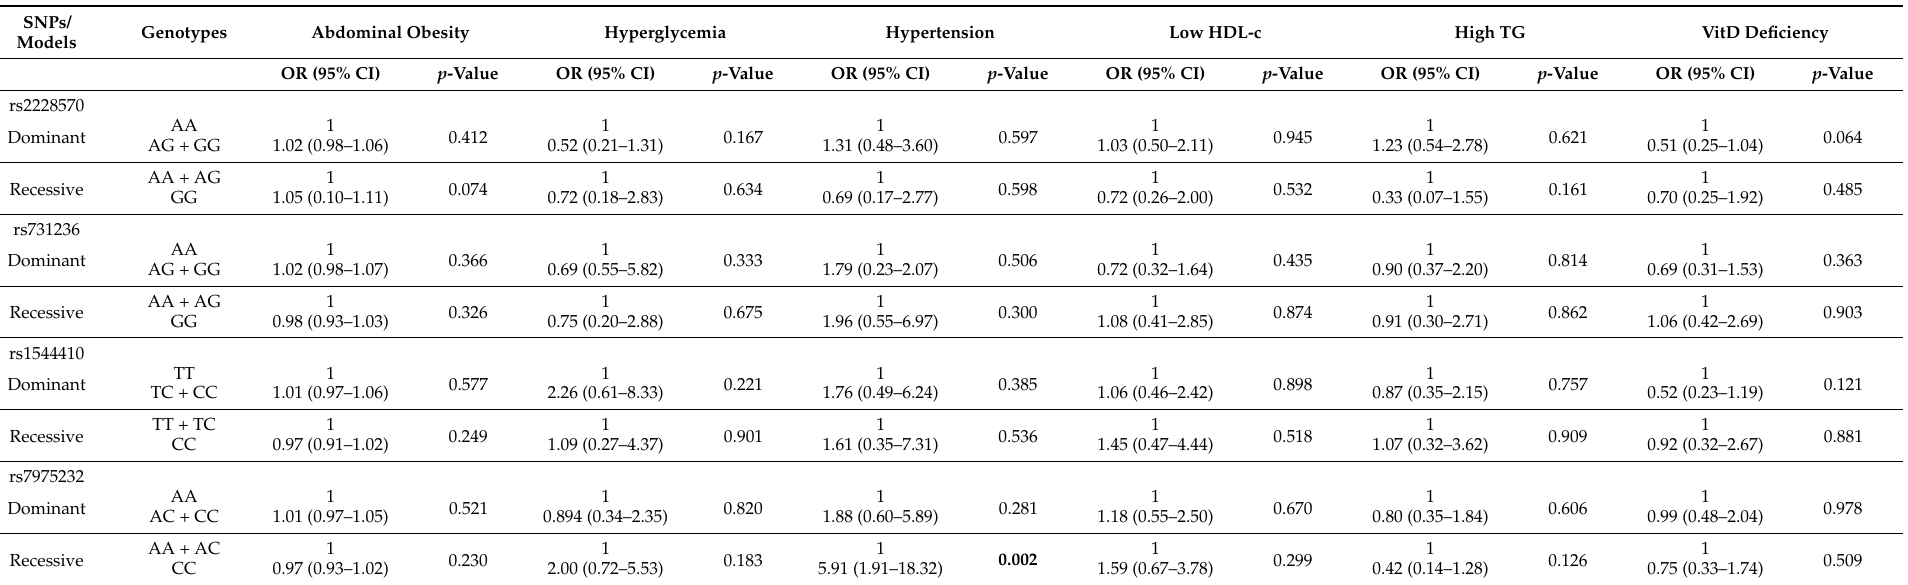
Table 5. Association of VDR polymorphisms with components of MS and vitamin D